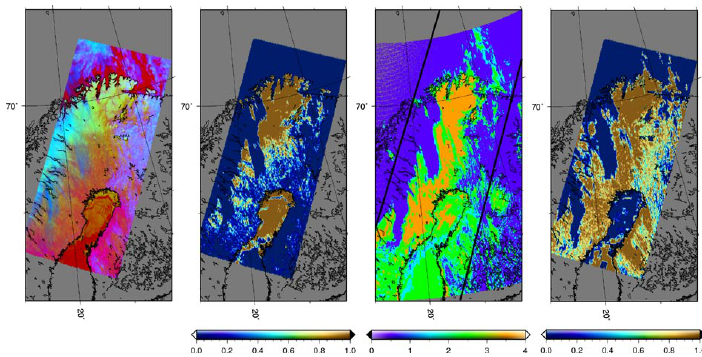
Figure 11. Scandinavian Peninsula, AATSR: 22 April 2006, 09 h 47'27'', orbit number 21661. MODIS: 22 April 2006, 09 h 40'. Left panel is the false color composite (red is 11µm BT, green is 550nm reflectance, blue is 1.6 µm reflectance) of initial AATSR scene; second left panel is the clear snow mask of AATSR scene (0 – not snow, 1 – clear snow) achieved with presented method; third left panel is MODIS cloud mask: 1 – cloudy, 2 – probably cloudy, 3 – probably clear, 4 – clear; right panel is operational AATSR cloud mask from level-0 product: 0 – cloudy, 1- clear.